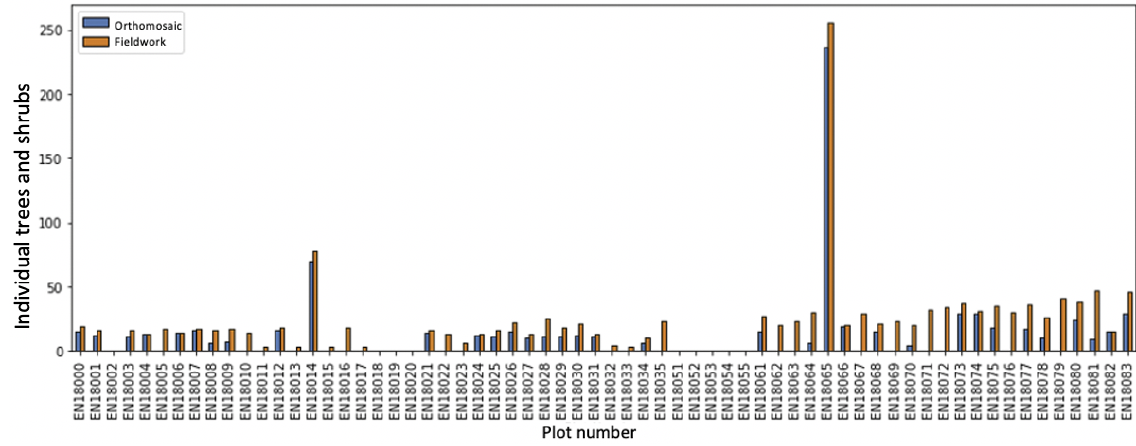
Figure 16. Number of individual trees recorded in the field (orange color) and visually identified and relocated (blue color) in the red–green- blue (RGB) orthomosaics per plot. For plots EN18014 and EN18065 all trees were recorded that were present on the